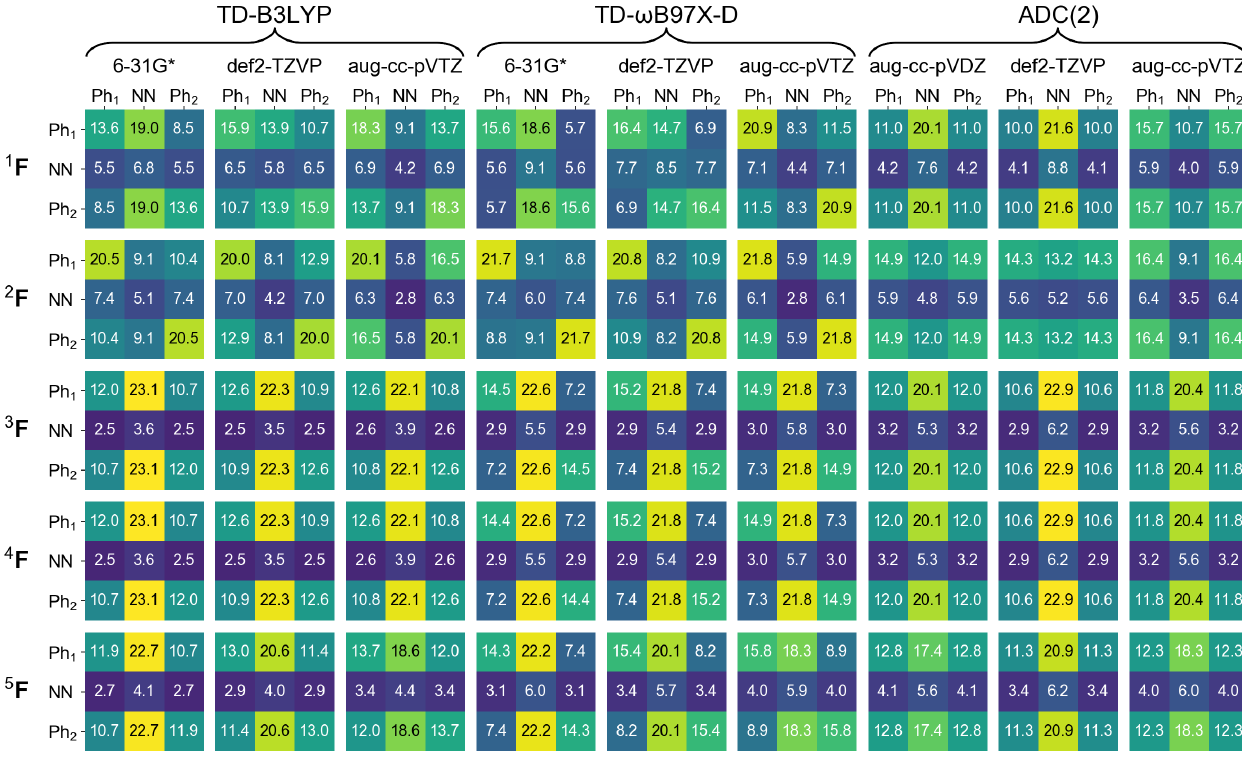
Figure 3. FTDM matrices 1 F , . . . , 5 F for the S 0 → S 2 transition of azobenzene calculated with nine methods indicated in the top. FTDM elements are expressed in %, i.e., multiplied by